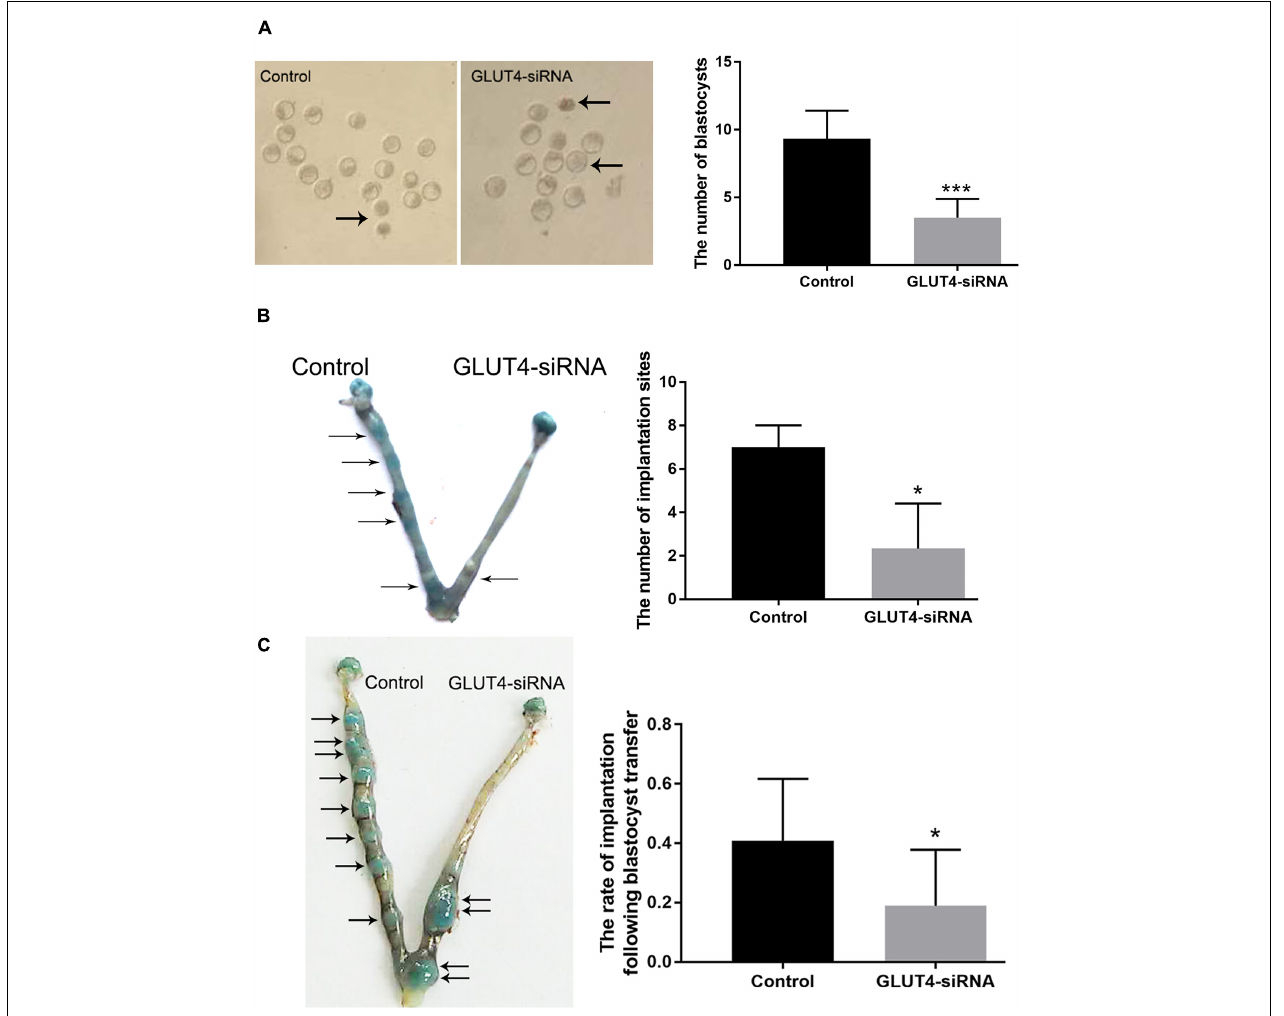
FIGURE 5 | Effect of GLUT4 on embryonic development and implantation. (A) On pregnant day 4, embryonic development was observed. Arrows indicate abnormal blastocysts. The number of normal blastocysts in the GLUT4-siRNA side was obviously decreased compared to that in the control side (3.5 ± 0.6 vs. 9.3 ± 0.8, *** P < 0.001 vs. control, n = 12). (B) On pregnant day 5, the implantation site was observed. The number of implantation sites in the GLUT4-siRNA side was significantly decreased compared to that in the control side (2.3 ± 1.2 vs. 7 ± 0.6, * P < 0.05 vs. control, n = 12). (C) Embryonic implantation rates on pregnant day 5 of embryo transfer. Eight blastocysts from donor mice were transferred into one uterine horn of each recipient mouse. The implantation rate in the GLUT4-siRNA side was significantly lower than that in the control side (0.19 ± 0.07% vs. 0.41 ± 0.07%, * P < 0.05 vs. control, n = 12).